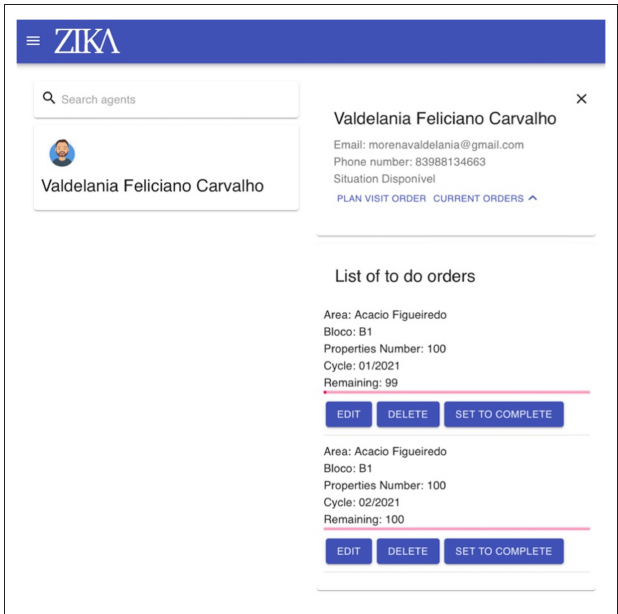
FIGURE 5 | Home page of the managers dashboard showing the interface used by managers for selecting and viewing agent details, and for allocating and assigning tasks to agents